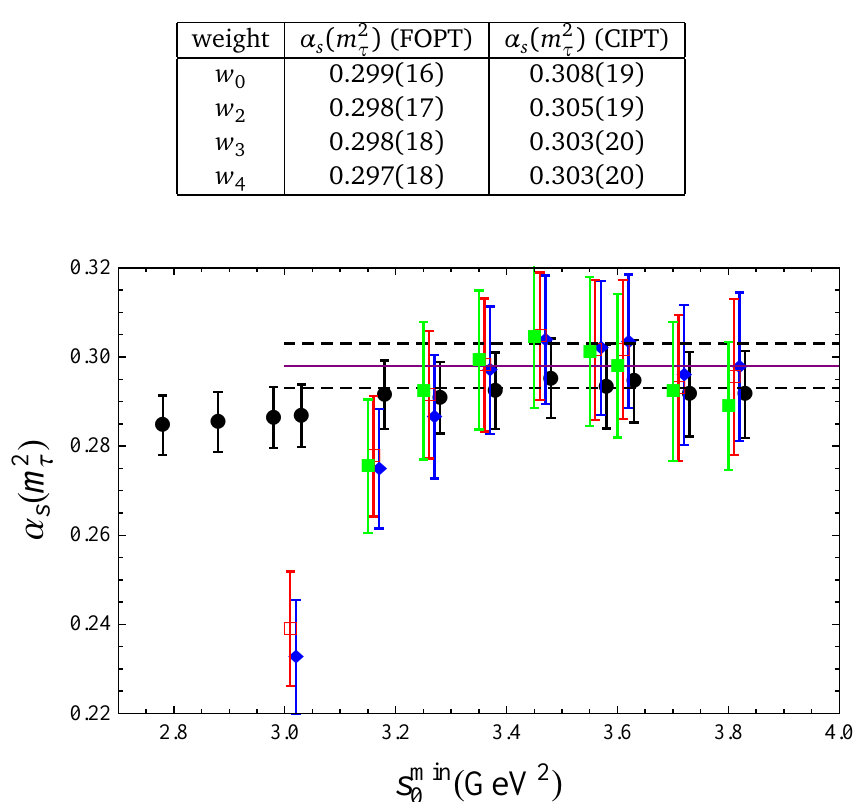
( m 2 ) obtained from the various weights, with FOPT values in Table 2: Values for α τ s the second column, and CIPT values in the third.